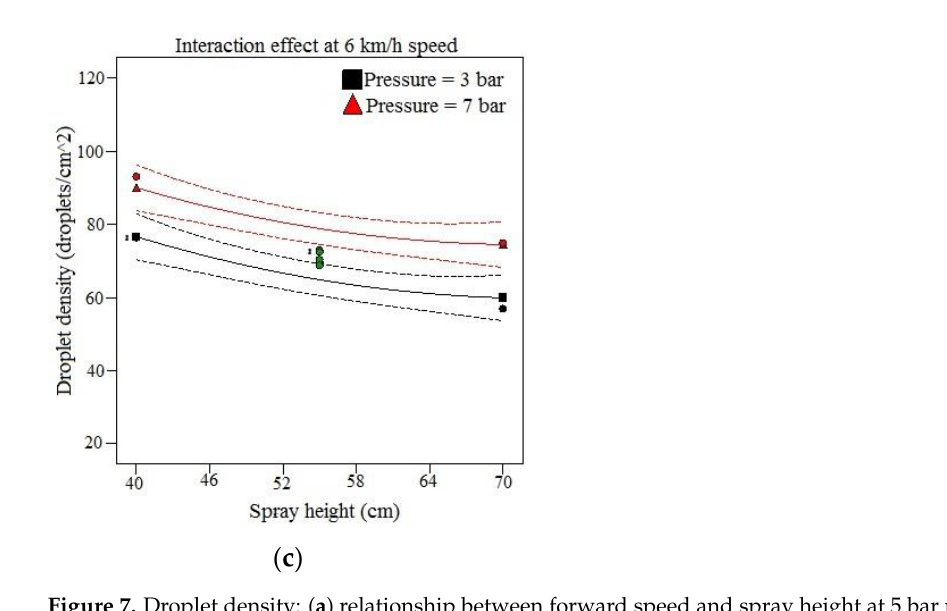
Figure 7. Droplet density: ( a ) relationship between forward speed and spray height at 5 bar pressure; ( b ) relationship between forward speed and pressure at 55 cm spray height; ( c ) relationship between spray height and pressure at 6 km/h speed.